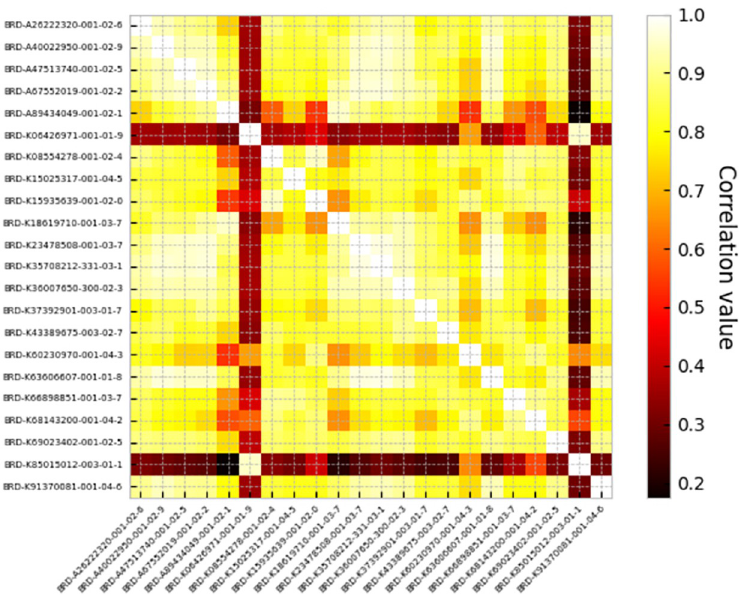
Fig 7. Correlation between toxic